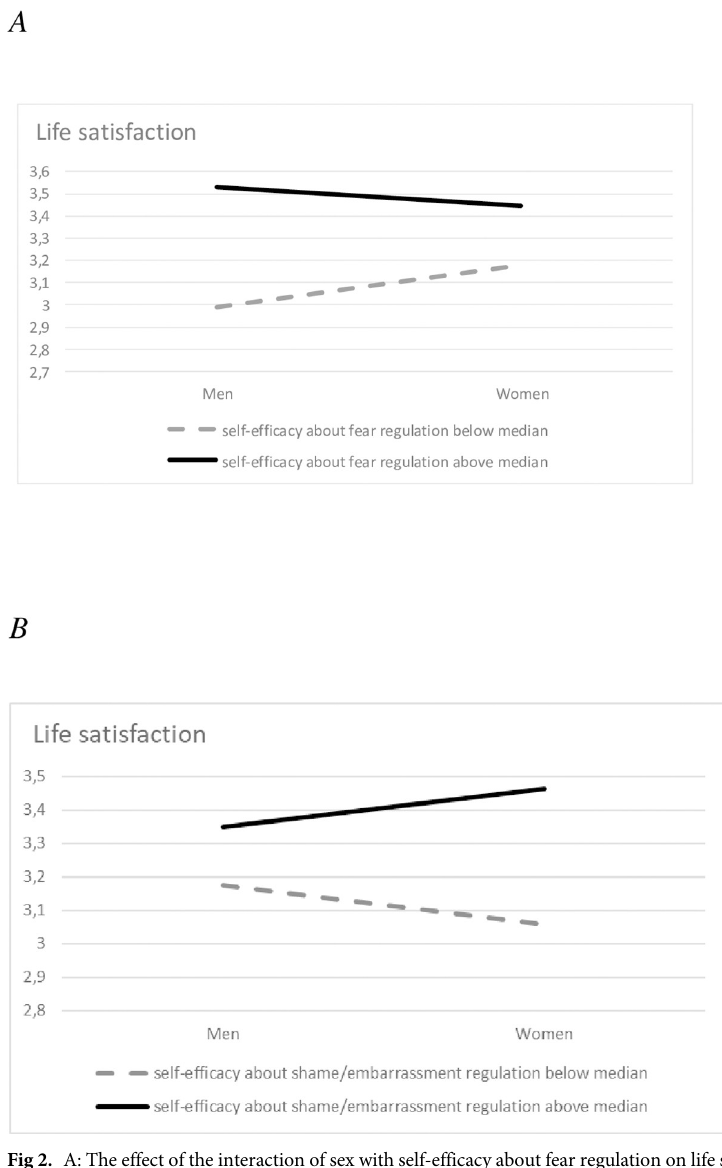
Fig 2. A: The effect of the interaction of sex with self-efficacy about fear regulation on life satisfaction. B: The effect of the interaction of sex with self-efficacy about shame/embarrassment regulation on life satisfaction.